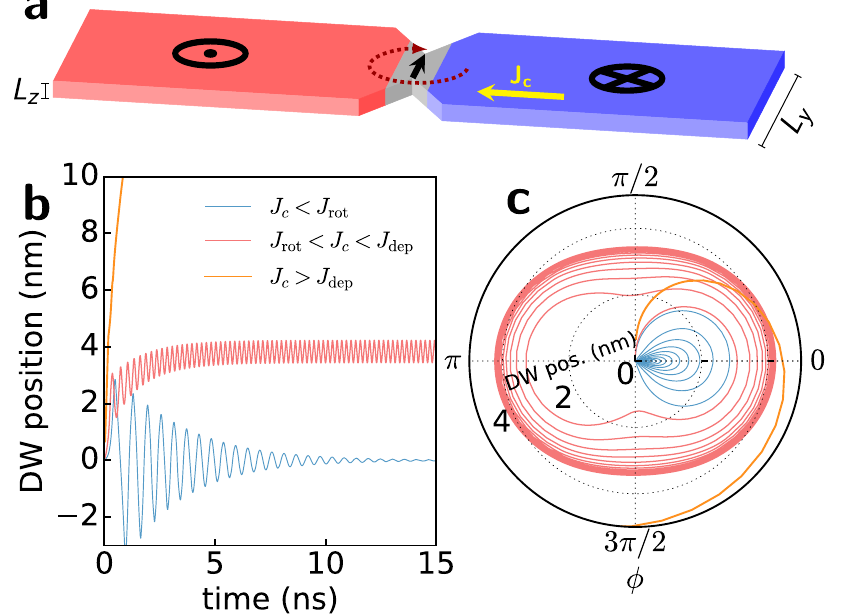
Figure 1. Scheme of the system under study and DW dynamics representation. ( a ) A DW located at a symmetric notch separates the up (red) and down (blue) domains. Current flows from right to left so that the induced rotation of the DW is clockwise. The in-plane direction of rotation is marked. ( b) DW position as a function of time in micromagnetic simulations with current values below (dark blue line), inside (purple line) and above (orange line) the pinned rotation window. ( c ) Data from the same simulations as in ( b ) plotted to represent DW position q as the radial coordinate and the DW angle φ as the polar